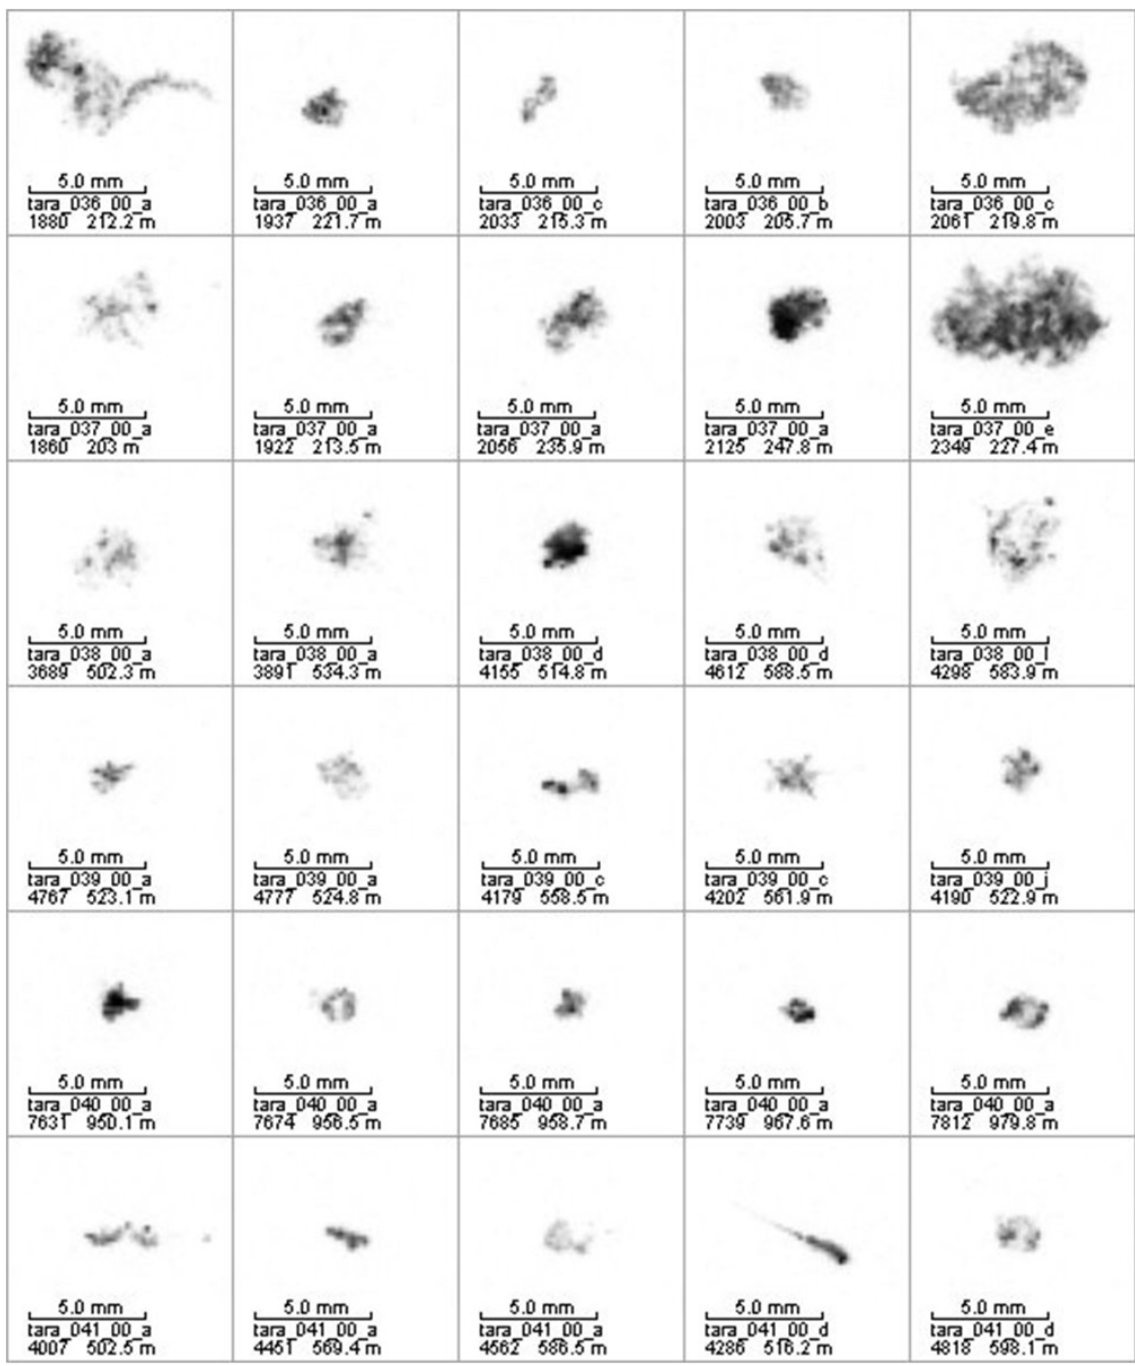
Figure 10. Examples of large aggregates observed at station 36 to 41 (depth is indicated on